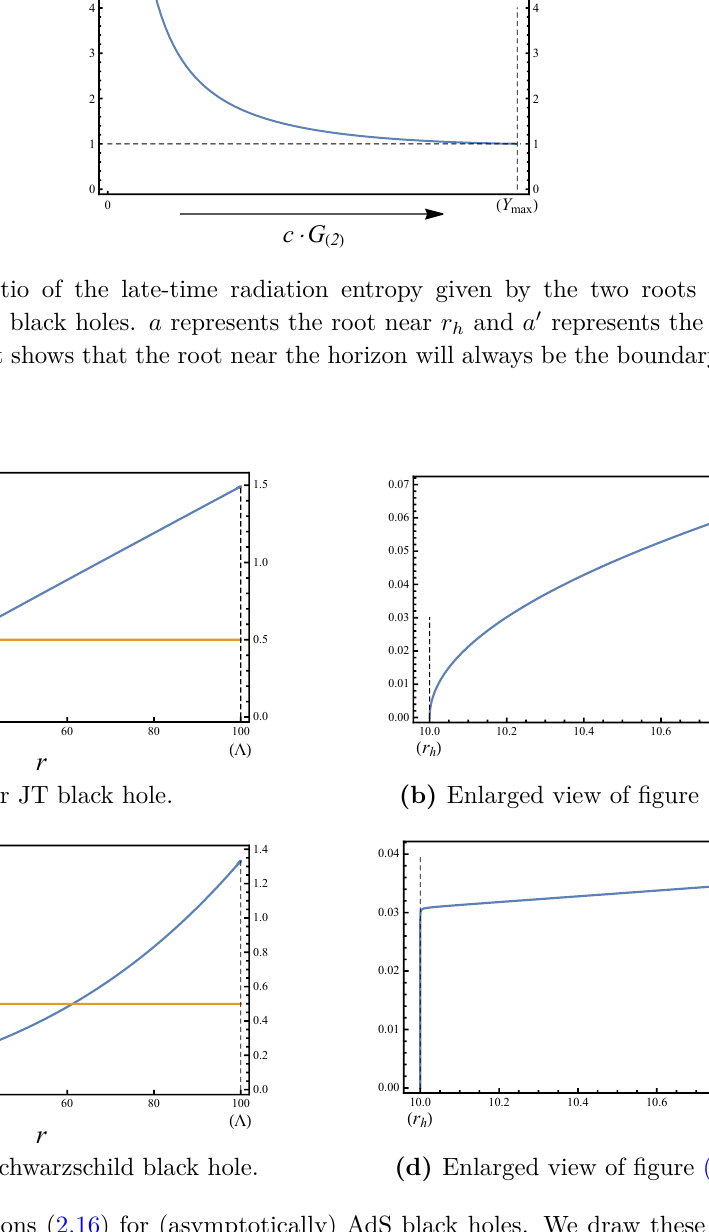
(d) Enlarged view of figure (c) at r h . Figure 6. Y -functions (2.16) for (asymptotically) AdS black holes. We draw these diagrams by setting r = 10 , L = 100 , r ∗ = 0 , Λ = 10 r ( λ = 10 − 2 for h h b